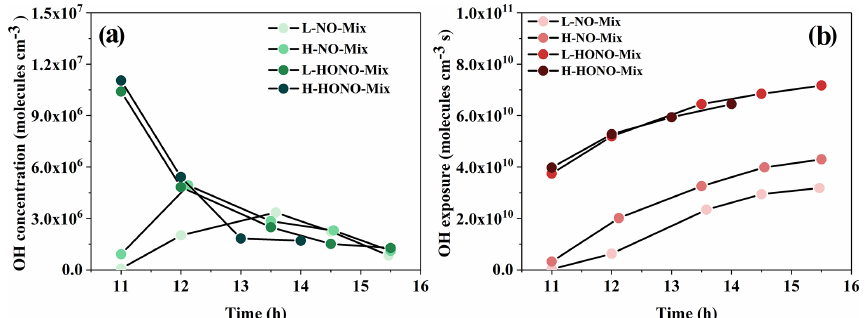
Figure 1. (a) OH radical concentration and (b) OH exposure versus time (hour) for mixture experiments. Each data point in this figure represents the average value (average OH concentration for a , average OH exposure for b ) during the two sampling time periods. The point at 11:00LST represents the average value of the data during the period from reaction initiation to 11:00LST.